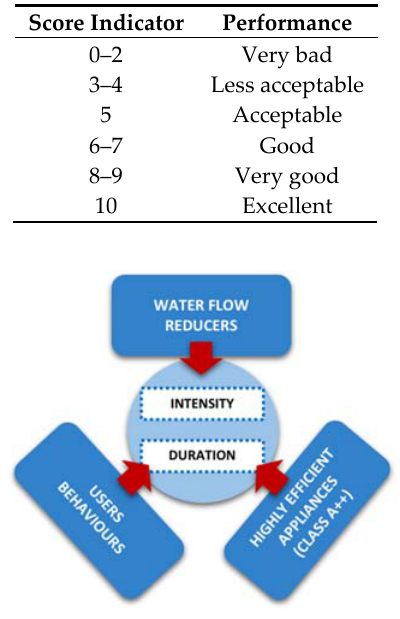
Table 3. Global Indicator scoring values.